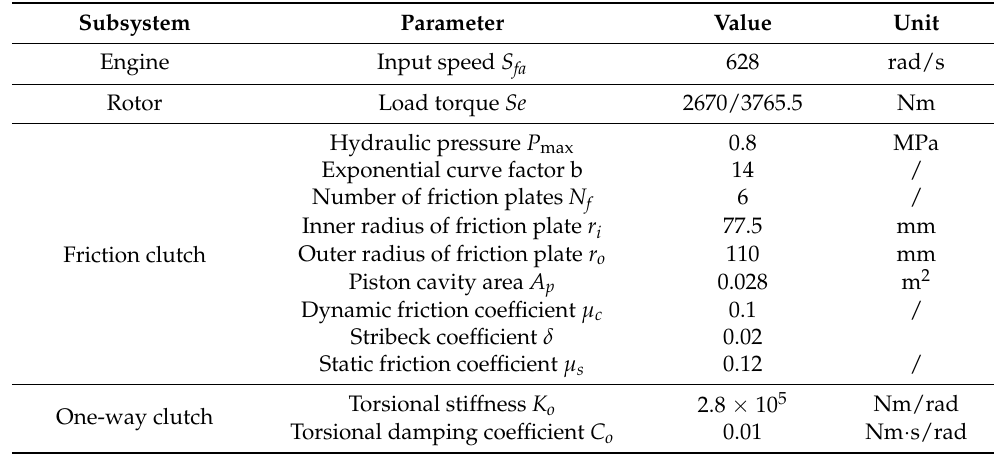
Table 3. Numerical simulation